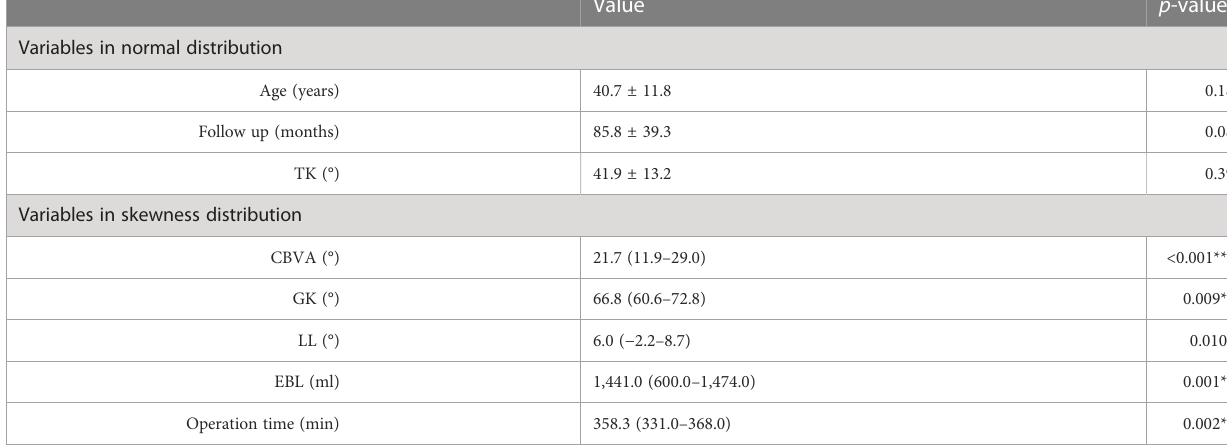
osteotomy plane (Figure 3). For the intra-pedicular screw fi xation, the VBCO group (model 2) had a more average distributed and lower stress condition on both nails and connecting rod than in the eggshell group (model 1). Compared with the VBCO group (model 2), the eggshell group (model 1) had a more variable high stress in lateral bending, especially left side bending and rotation than in other conditions and the stress was aggregated centrally on the middle of the connecting rod, mainly distributed in the osteotomy area. The VBCO group (model 2) had a fl attened osteotomy plane compared to the pitted osteotomy plane of the eggshell group (model 1). It made the VBCO group (model 2) show a lower and more average distributed maximum stress and displacement of the osteotomy plane than the eggshell group (model 1). Overall, the compression model obtained better FEA mechanics stability than the eggshell model.